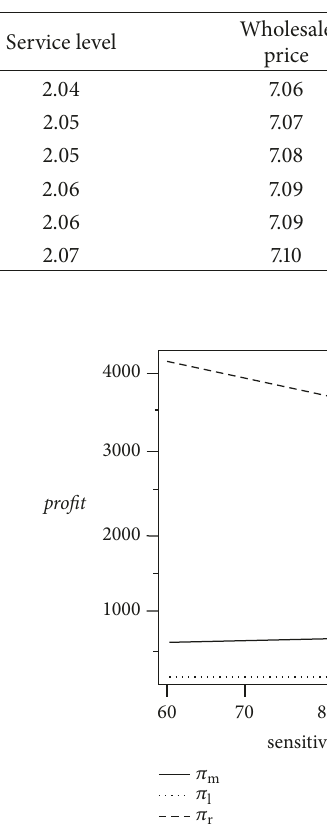
Figure5:Theeffectofthesensitivitycoefficientoftheorderquantity to the logistics service price on the supply chain members’ profits.